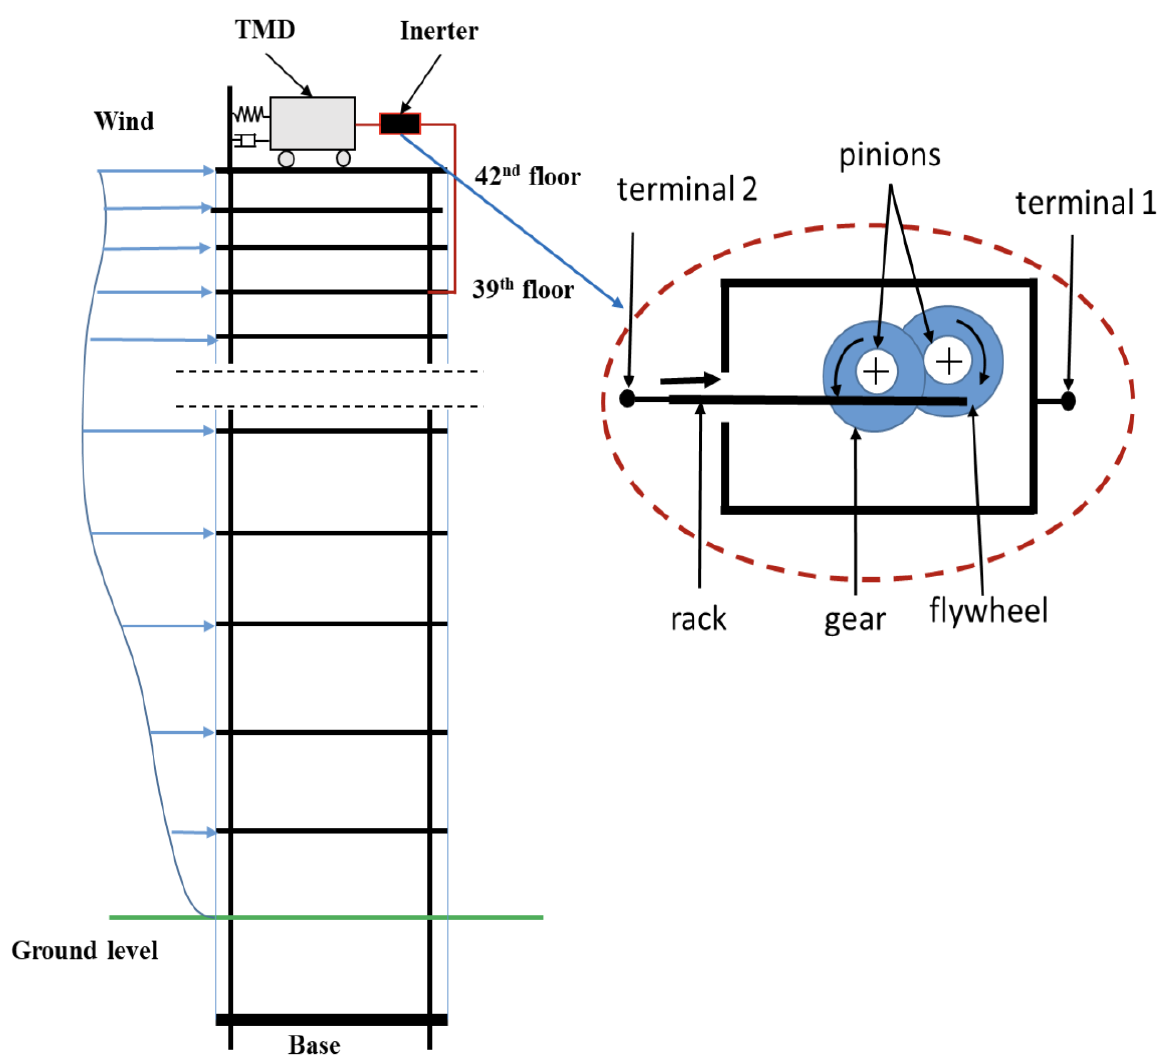
Figure 5. Schematic of a high-rise building equipped with a TMDI.